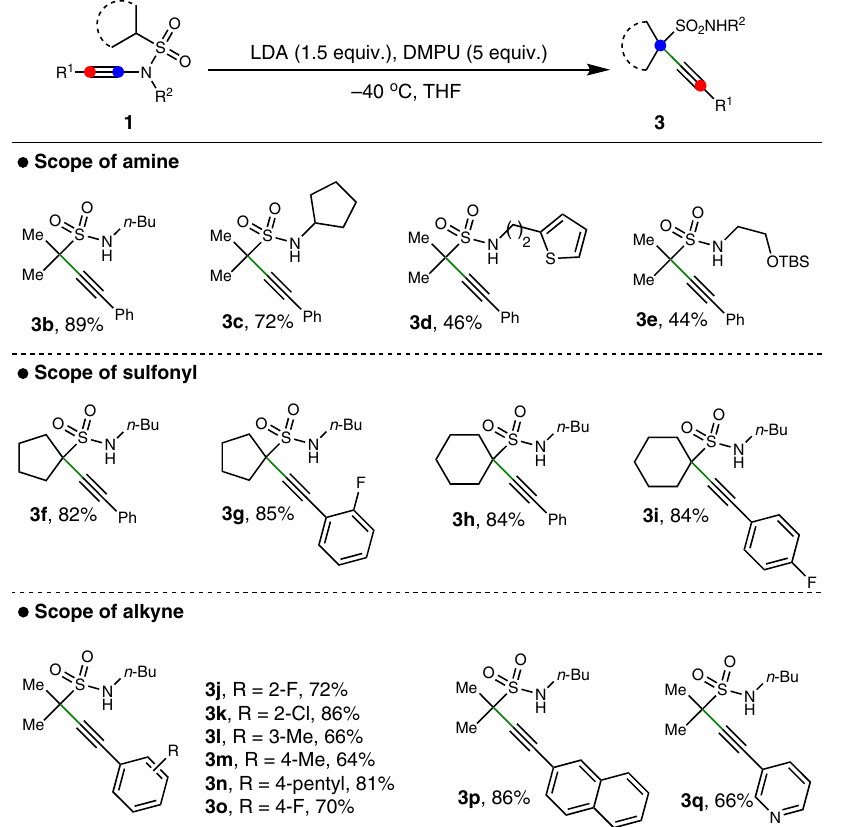
Fig. 5 Scope of propargyl sulfonamides. Standard condition: 1 (0.2 mmol), LDA (0.3 mmol), DMPU (1 mmol), THF (2 mL), − 40 °C, 1 h, then treated with MeOH (0.1 mL). Yields refer to isolated